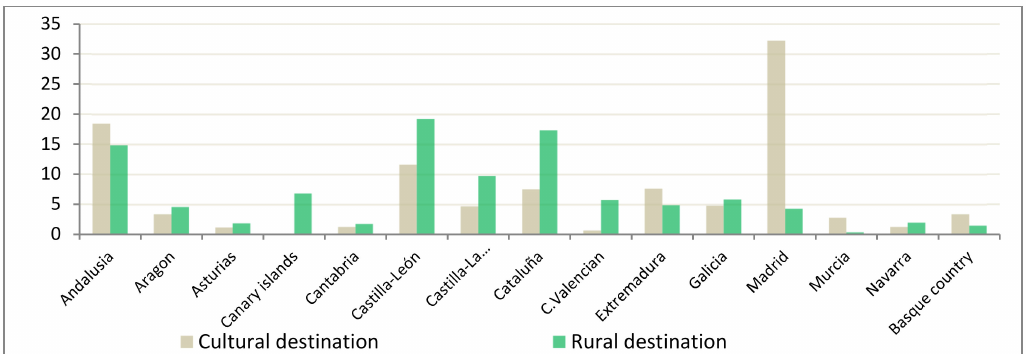
Figure 2. Rural tourism and cultural tourism by Spanish regions (percentage).